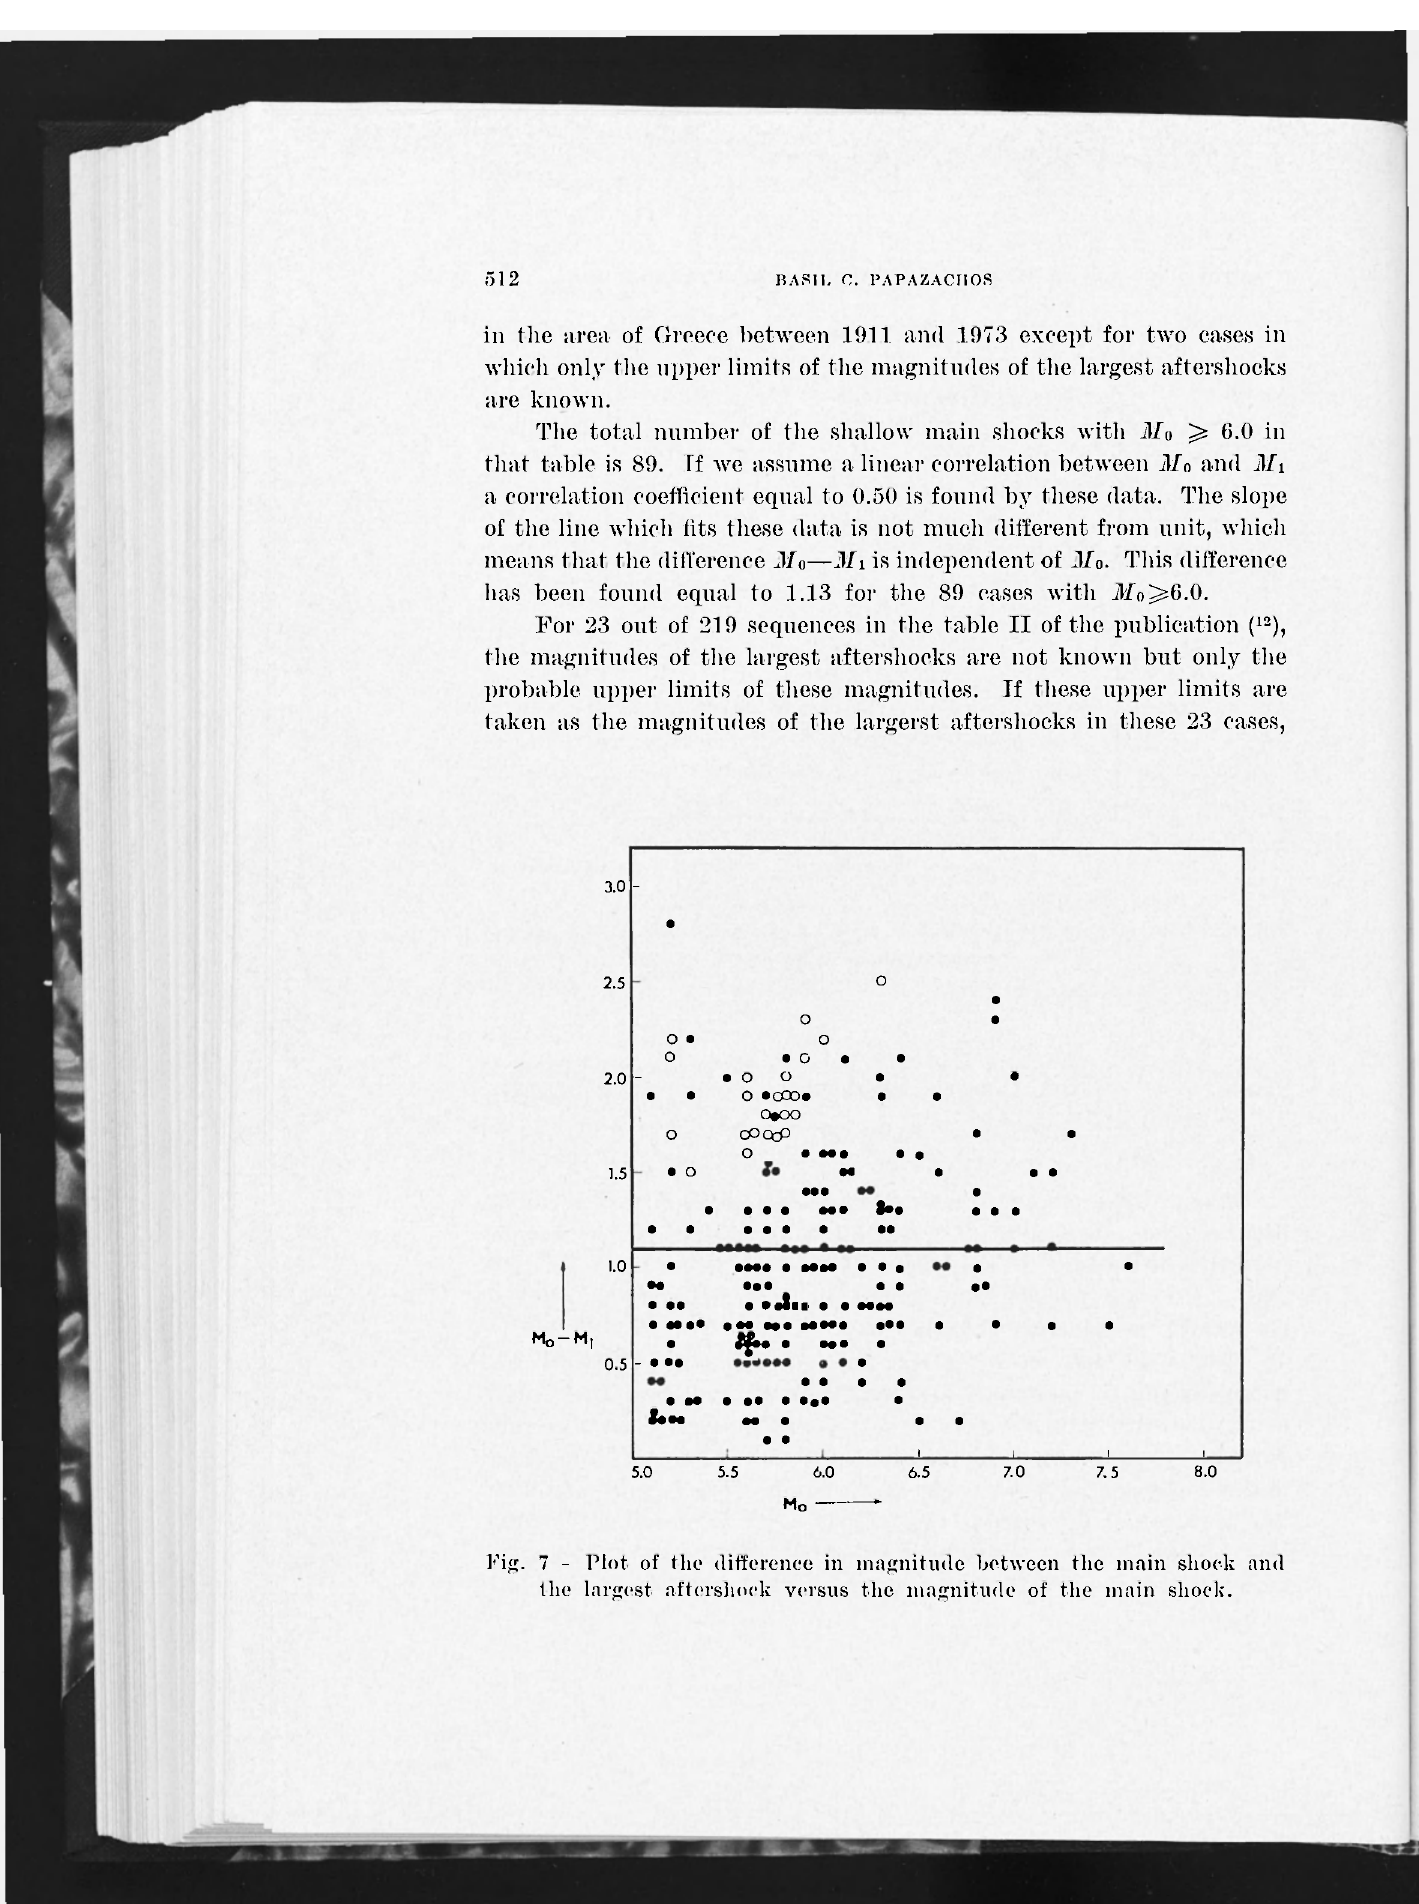
Fig. 7 - Plot of the difference in magnitude between the main shock and the largest aftershock versus the magnitude of the main